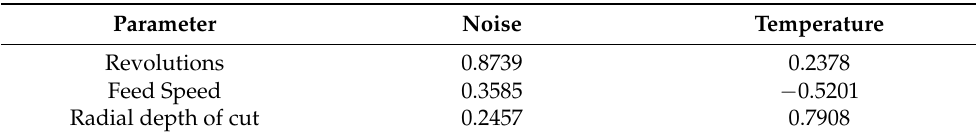
Table 3. The value of the correlation coefficient r xy between the machine parameters and the meas- ured temperature and noise parameters.